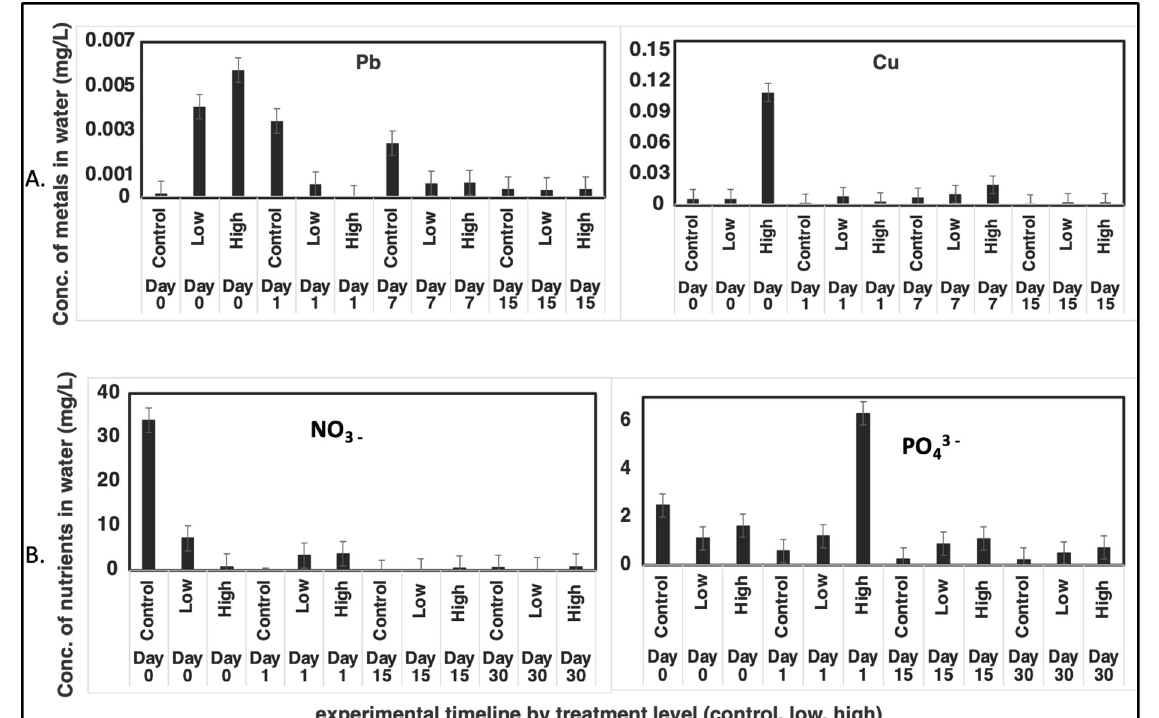
Figure 5. ( A ) Median concentration of Pb and Cu (mg/L) in metal microcosms (for wetland sites 1–4) at days 0, 1, 7, and 15 of the experiment. ( B ) Median concentration of NO 3 − and PO 43 − (mg/L) in nutrient microcosms (for wetland sites 1–4) at days 0, 1, 15, and 30 of the experiment. This test in- cluded a control treatment where no pollutants were added, accompanied by sets of low and high concentrations in the treatment microcosms, where metals (Pb and Cu) and nutrients (NO 3 − and PO 43 − ) were added to the water as per the experimental design in Table 2. Bars show mean ± 1 SE. Multifactor ANOVA tables are in Appendix A Table A1.